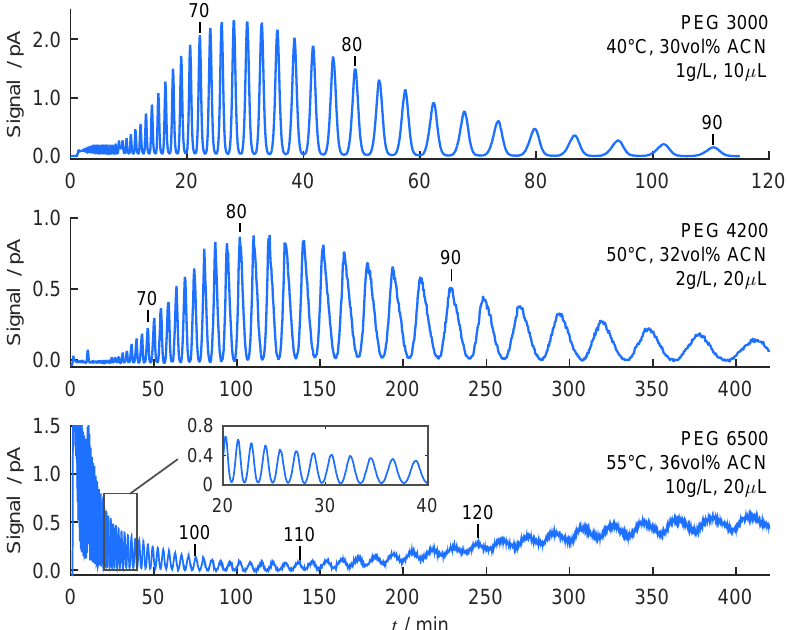
Figure 3. Selected examples for the separation of larger PEGs. Conditions (see labels) were adjusted to achieve about baseline resolution. Top —PEG3000 (average degree of polymerization ¯ n = 68). Mid- dle —PEG4200 (¯ n = 95; the actual average MW was estimated as 3900g/mol). Bottom